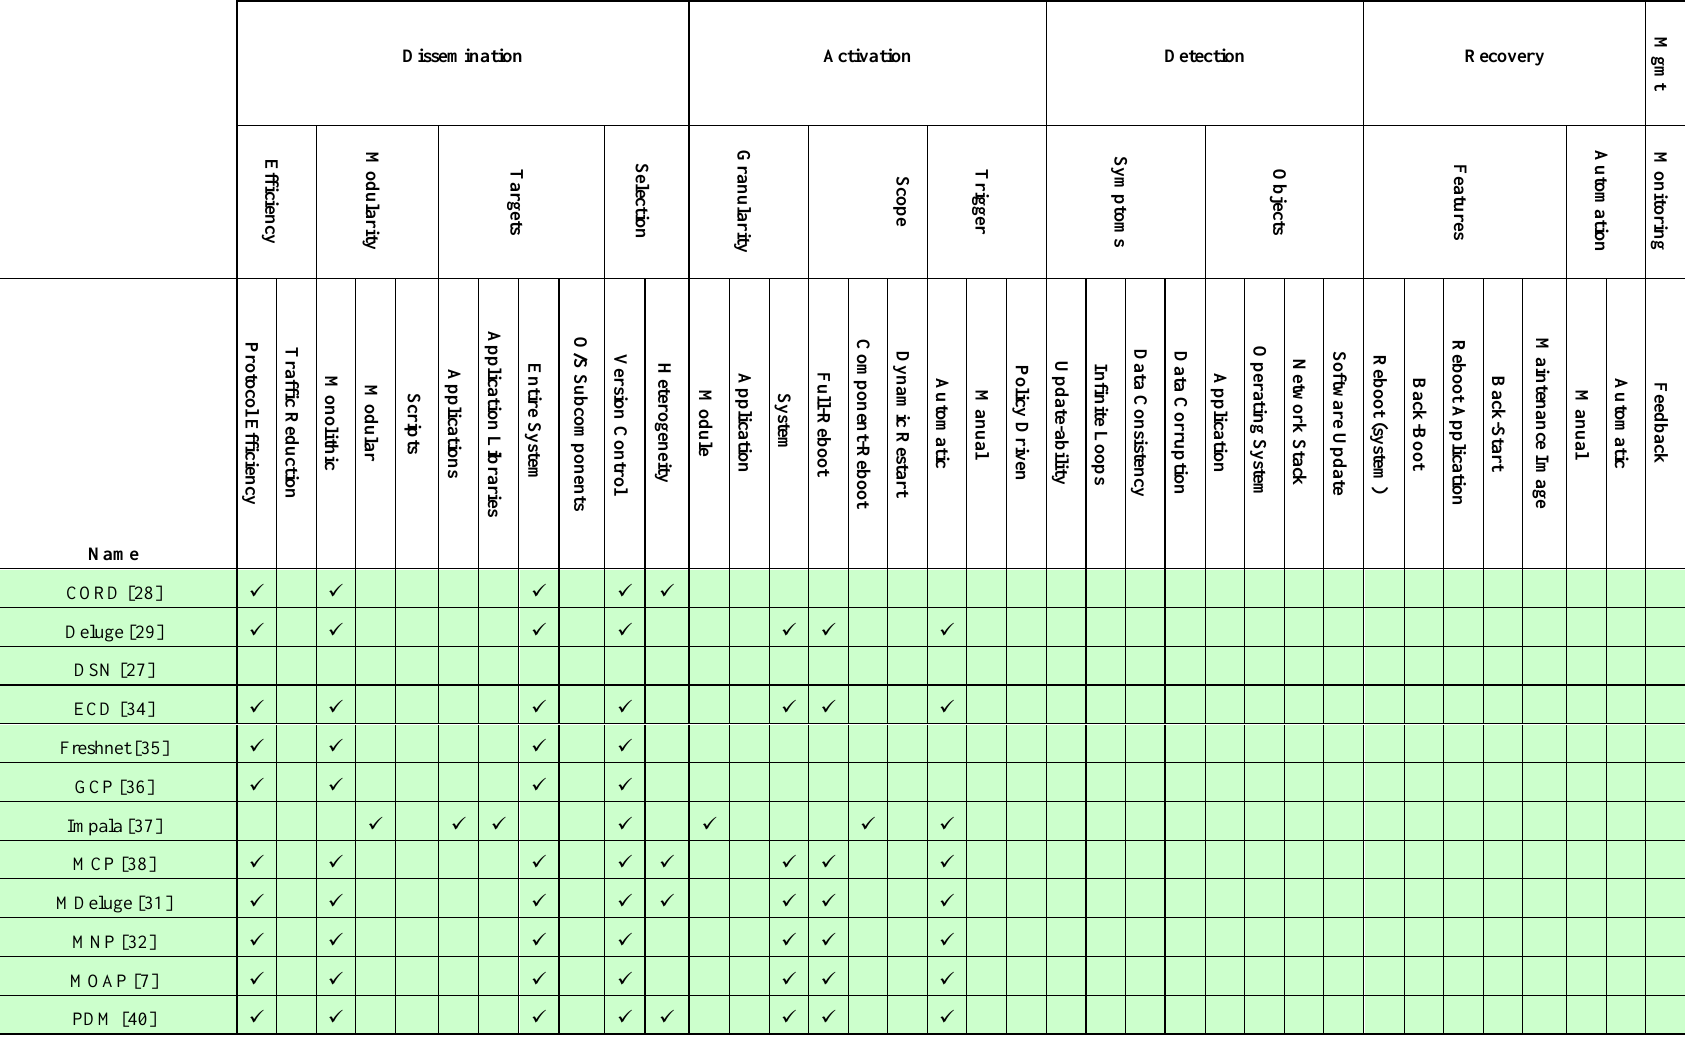
Table 1. Software and Configuration Updates (SCU) Feature